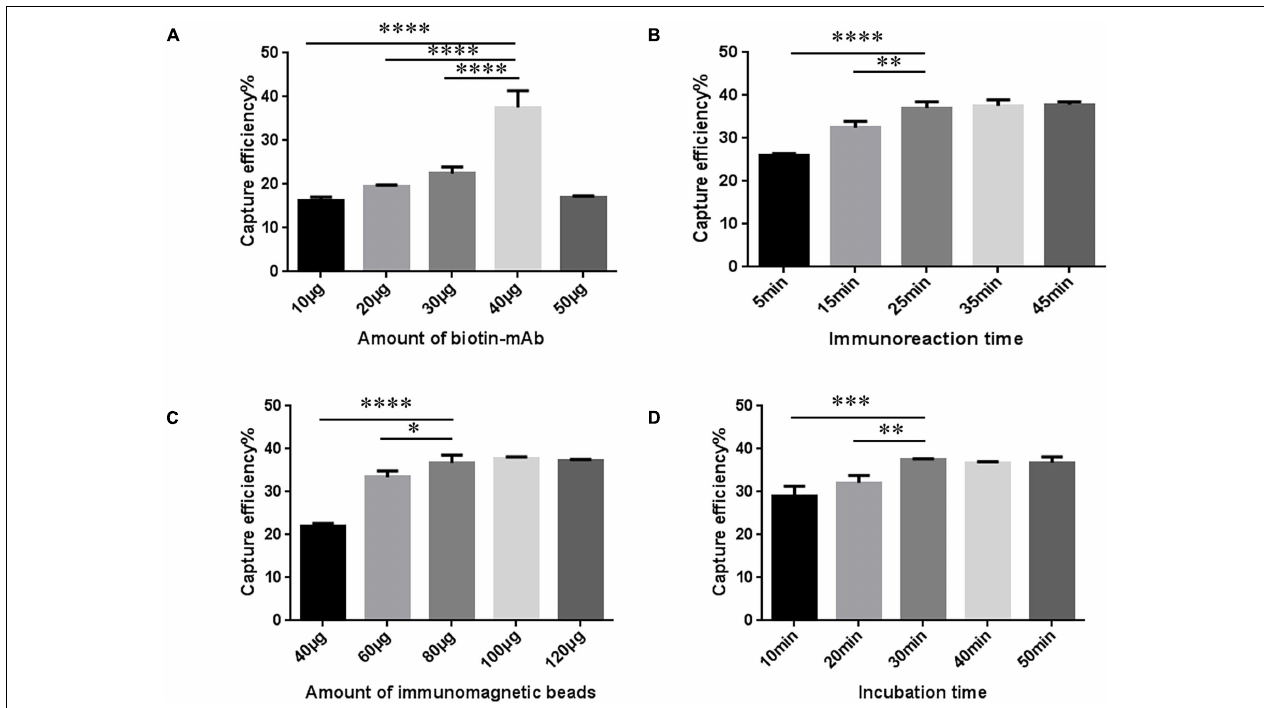
FIGURE 3 | Optimization of streptavidin-biotin amplified immunomagnetic enrichment (SA-BA-IME) conditions. (A) Amount of biotinylated monoclonal antibody (biotin-mAb) optimization. (B) Optimization of immunoreaction time of biotin-mAb with noroviruses. (C) Optimization of the amount of immunomagnetic beads. (D) Optimization of incubation time. Optimization of the amount of biotin-mAb, immunoreaction time, the amount of immunomagnetic beads, and incubation time that affect the capture efficiency (CE) of the SA-BA-IME. The best enrichment conditions are selected based on the principle of high CE, and time and cost saving. ∗ P < 0.05, ∗∗ P < 0.01, ∗∗∗ P < 0.001, ∗∗∗∗ P < 0.0001.